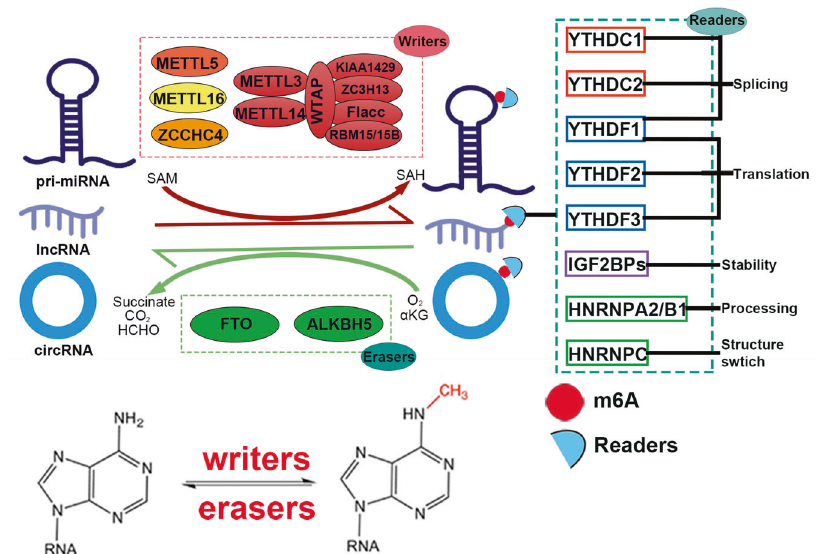
Fig. 2 The m6A modi fi cation is regulated by m6A “ Writers ” , “ Erasers ” , and “ Readers ” . The dynamic and reversible processes of m6A modi fi cation. “ Writers ” deposit m6A methylation on ncRNAs. “ Erasers ” remove the m6A modi fi cation on ncRNAs. “ Readers ” are responsible for recognizing the m6A modi fi cation on